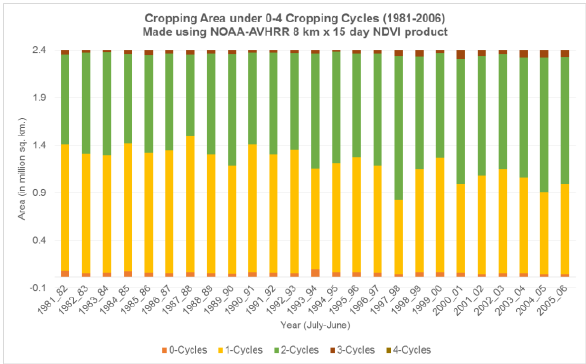
Figure 7: Area under different cropping cycles across 25 cropping years (1981-2006) using smoothed GIMMS NDVI time series